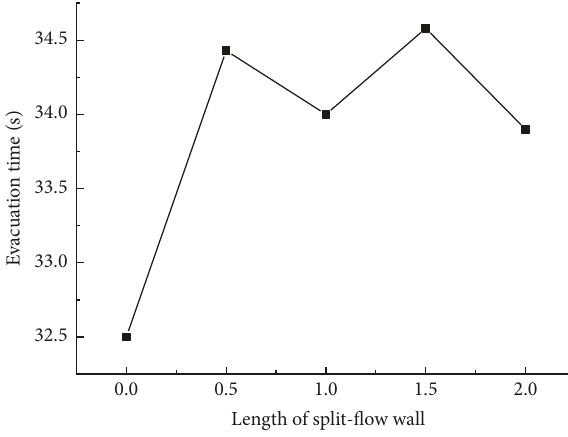
Figure 8: Evacuation time when 𝐷 = 0.5 , 𝜌 = 0.5